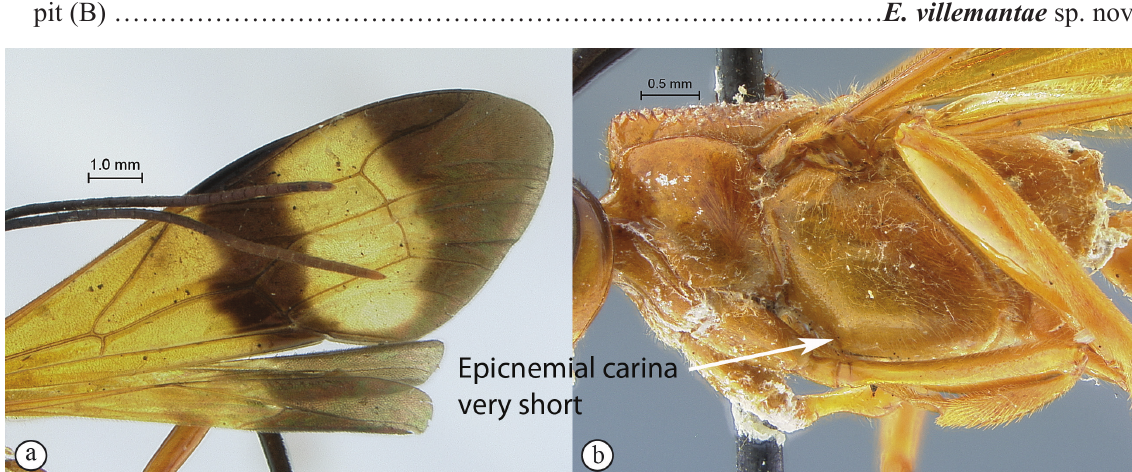
- Wings yellowish with apex blackish and an additional subapical transverse blackish band on fore wing (a); epicnemial carina very short, hardly extending onto mesopleuron (b) ……… E. maynei Benoit, 1952